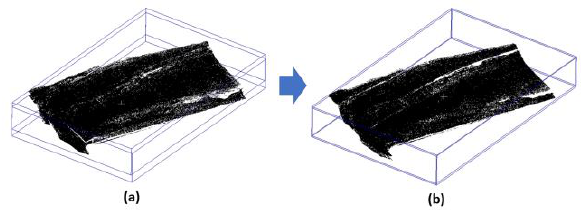
Figure 2. Point clouds registration using MBBC method – (a) before registration process, (b) after registration process (perspective view)